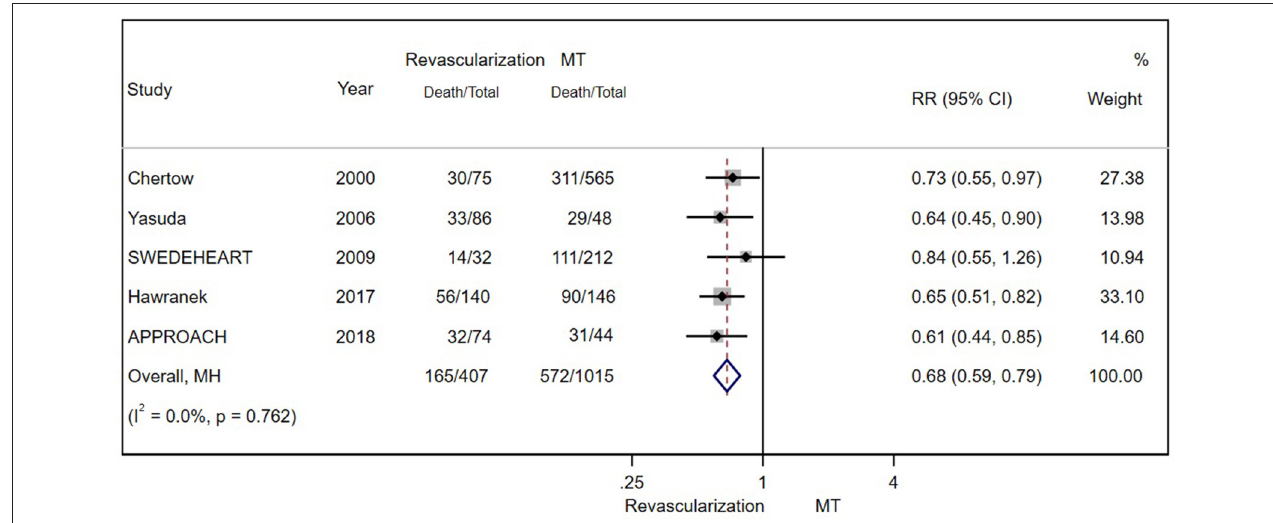
FIGURE 3 | The pooled effect of revascularization and MT alone on the long-term mortality of patients with CAD and estimated glomerular filtration rate (eGFR) ≤ 15 ml/min/1.73 m 2 or receiving dialysis treatment. Revascularization was more helpful than MT in reducing mortality. Weights and between-subgroup heterogeneity test are from Mantel-Haenszel